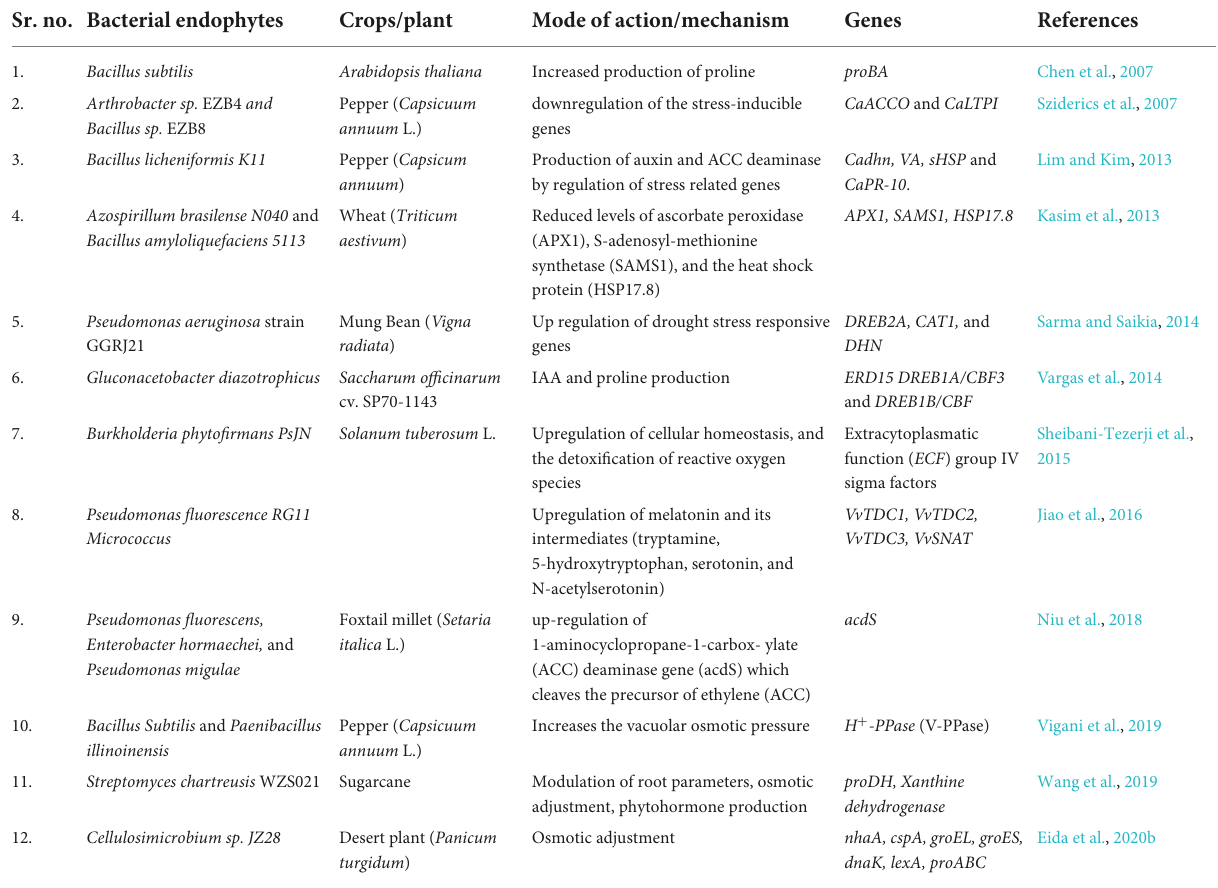
TABLE 1 Utilization of bacterial endophytes to improve stress tolerance response of host